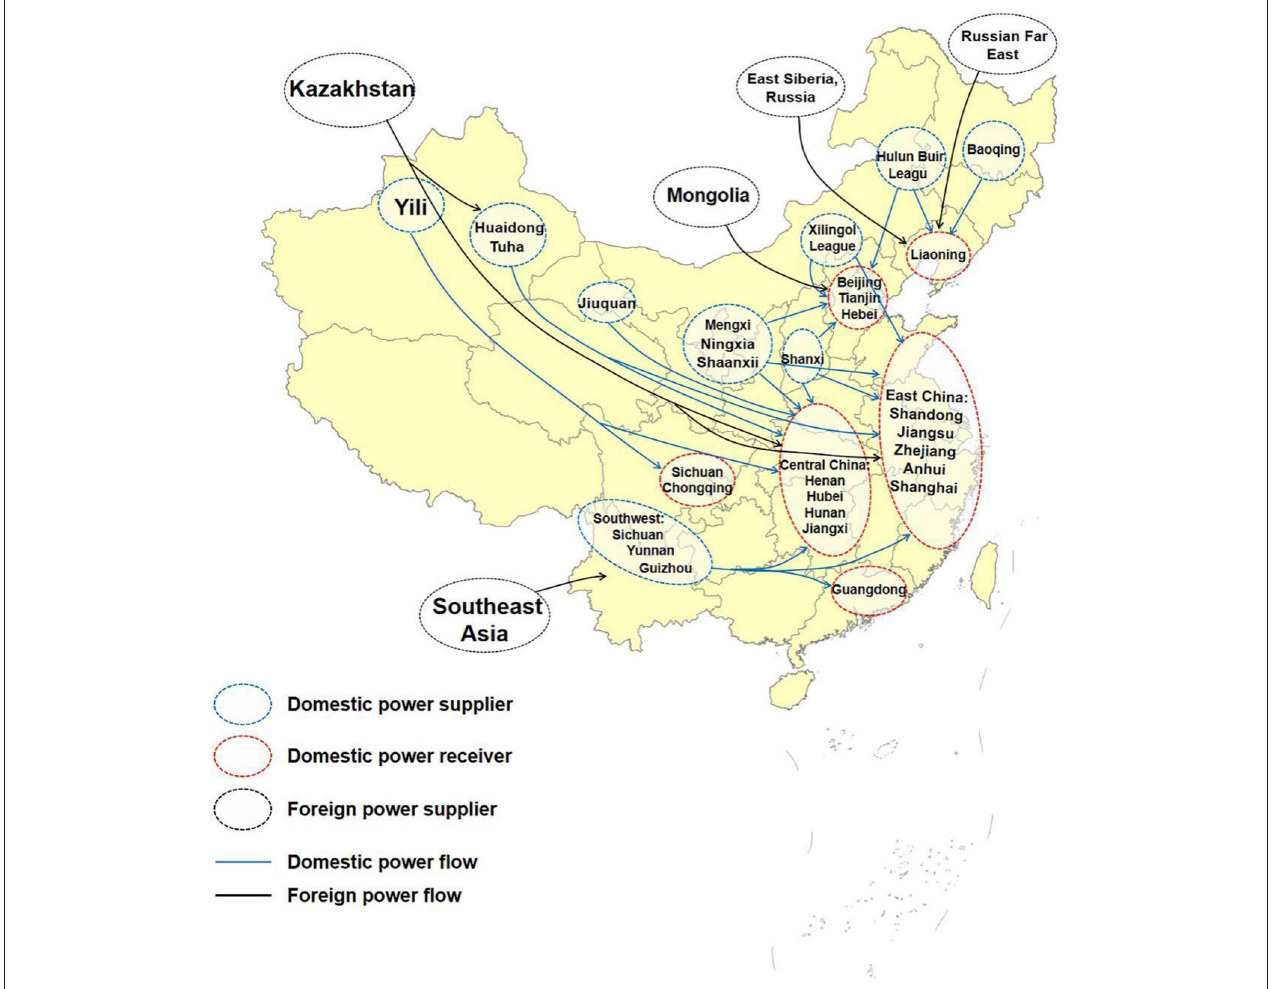
FIGURE 9 | National power